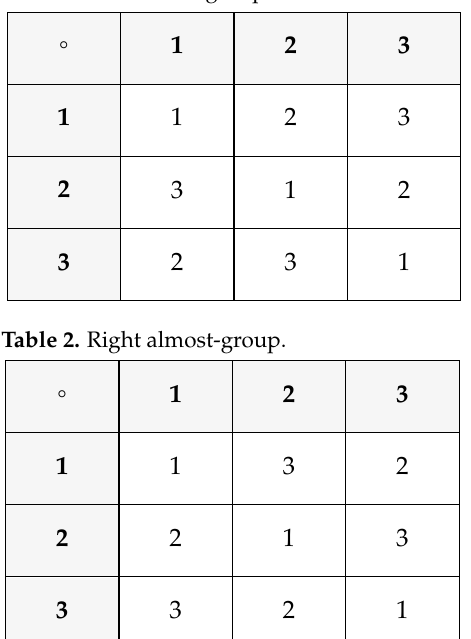
Table 1. Left almost-group.